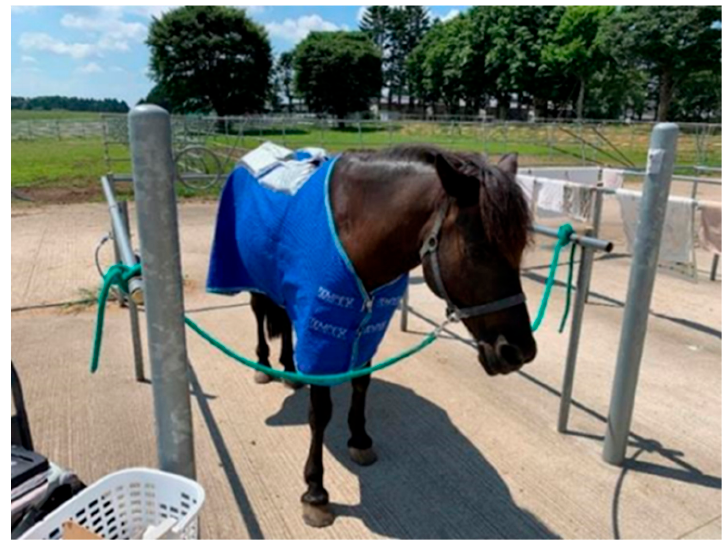
Figure 3. In the IB groups, the horses were equipped with ice horse